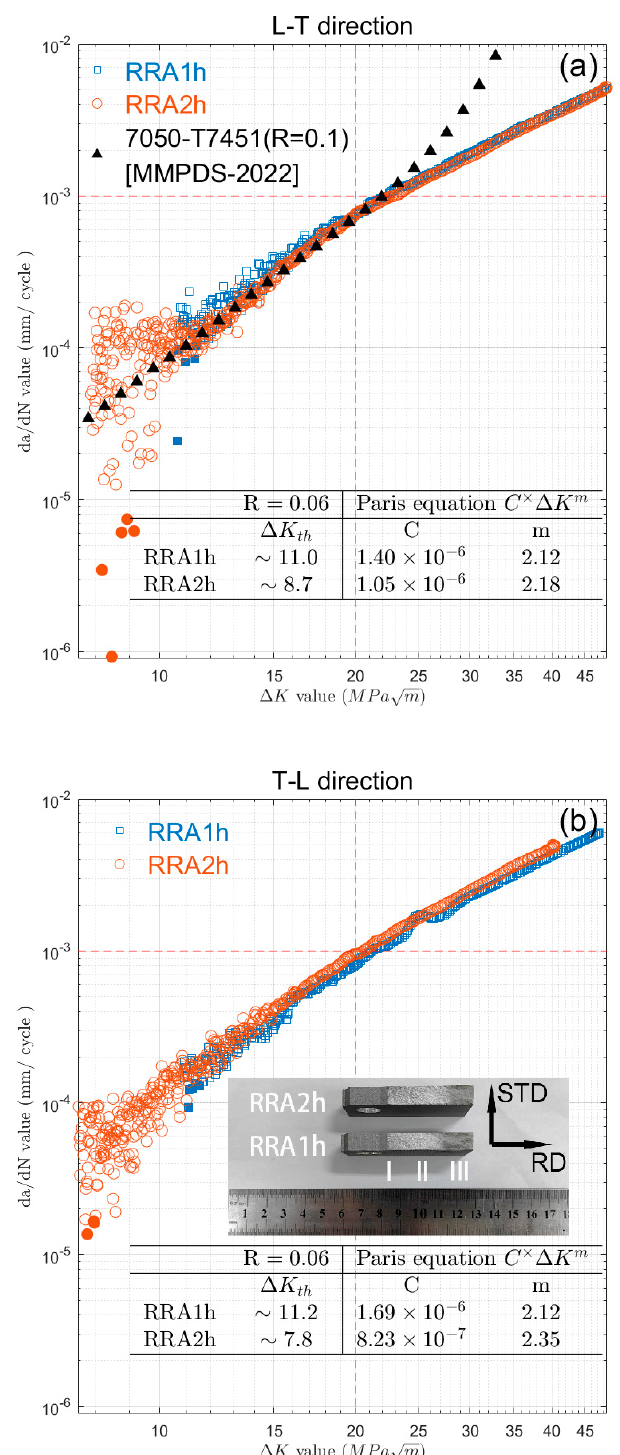
Figure 2. FCGR curves (da/dN vs. ∆ K) for alloy retrogression at 180 ◦ C for 1 h and 2 h for ( a ) L-T direction, the FCGR data of 7050-T7451 is from [30] and ( b ) T-L direction, the enclosed figure shows the fracture surface of tested samples.